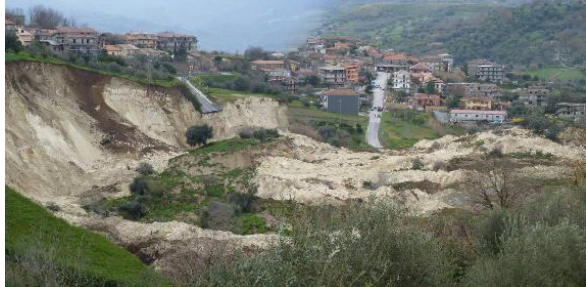
Figure 3. Soil waves on the bottom of the Scotrapiti valley